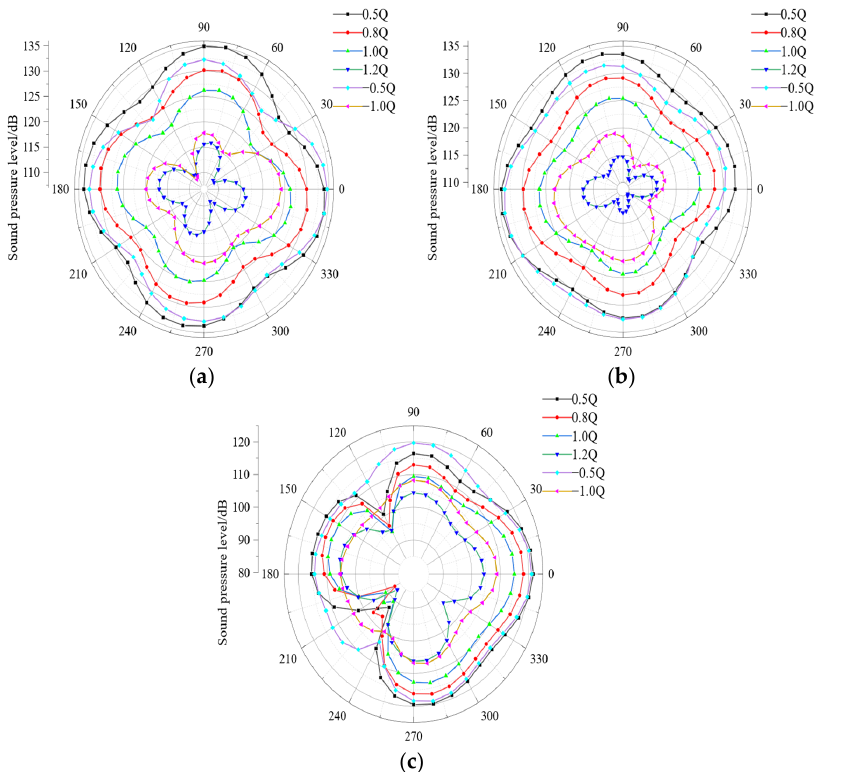
Figure 14. Noise directivity distribution at the sound source. ( a ) First ‐ order. ( b ) Second ‐ order. ( c ) Third ‐ order. ( c ) Third-order.